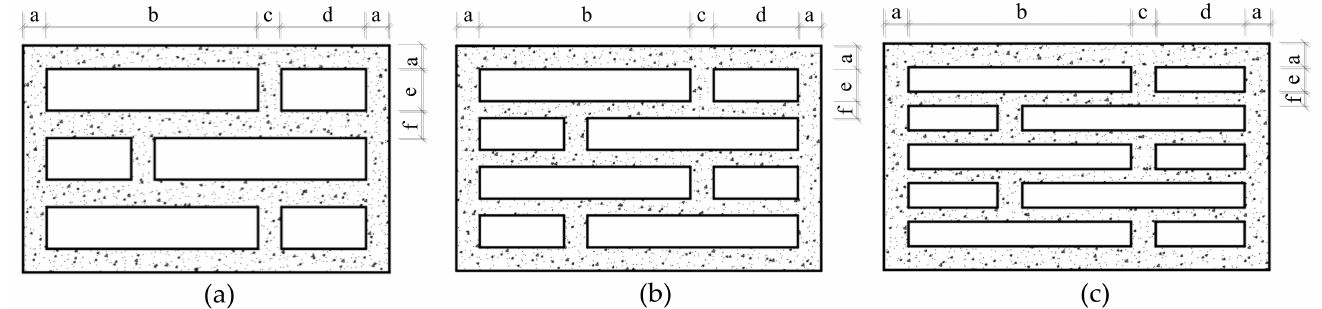
Figure 1. Diagram of AASCSIHBs. ( a ) Three rows of holes; ( b ) Four rows of holes; ( c ) Five rows of holes. The distance between rows of the rectangular holes was the same. The distance between the rectangular holes parallel to the length direction of the block was referred to as horizontal rib, and the value was c . The distance between the rectangular holes perpendicular to the width direction of the block was referred to as vertical rib, with a value of f . The length and width of the larger rectangle in each row of the hole were b and e , respectively. The length and width of the smaller rectangle were denoted by d and e , respectively. In addition, a was taken as 25 mm according to the reference [32]. The detailed dimensions of the AASCSIHBs are shown in Table